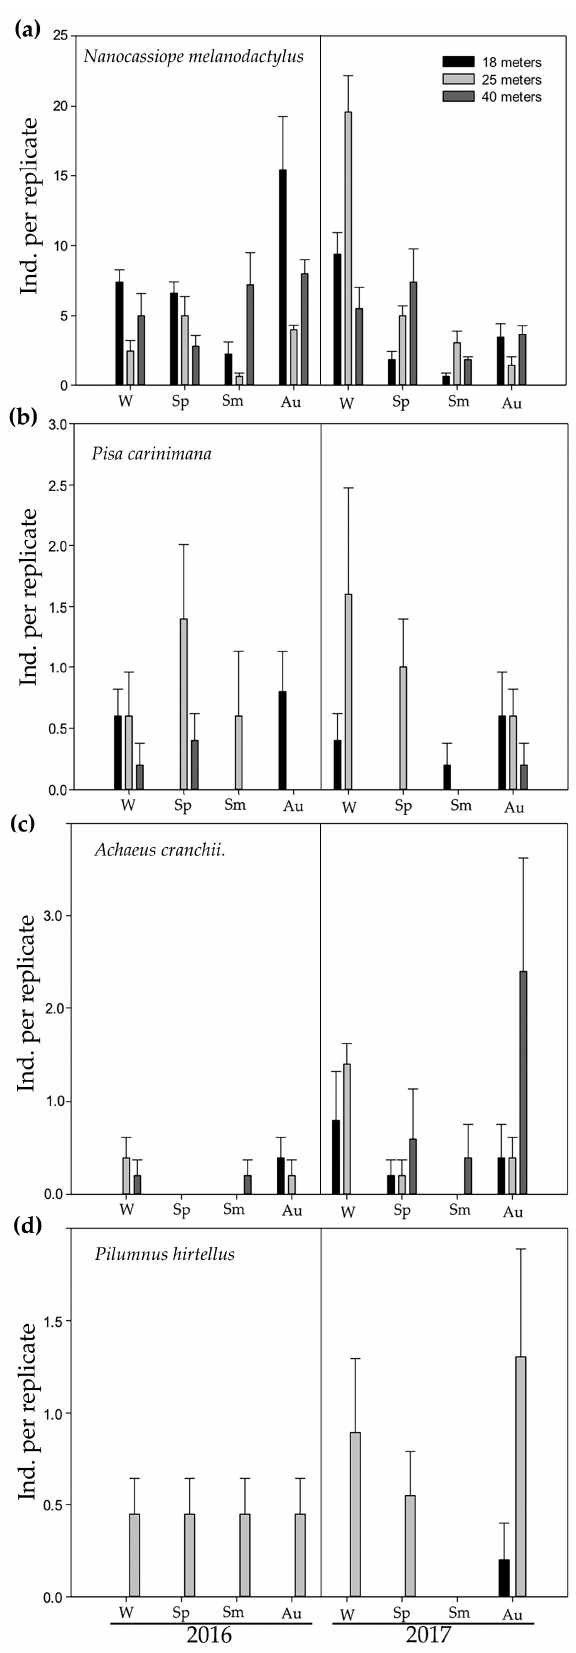
Figure 4. Abundance ( + SE of means) of ( a ) Nanocassiope melanodactylus , ( b ) Pisa carinimana, ( c ) Achaeus cranchii , and ( d ) Pilumnus hirtellus at different depths (18, 25, and 40 m) and seasons (W: winter, Sp: spring, Sm: summer, Au: autumn) in 2015–2016 and 2017. Scales are different among panels.